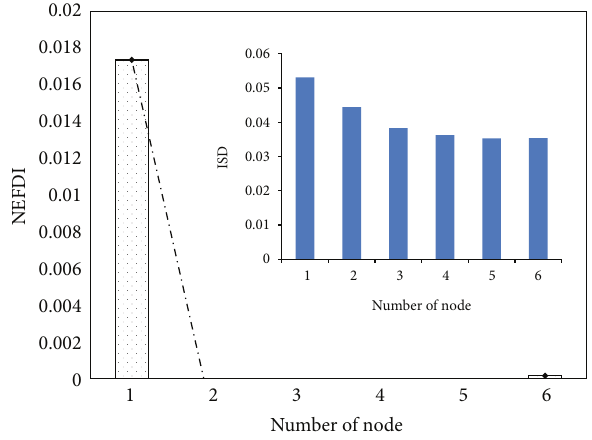
Figure 17: The identified damage locations: damaged on 1st